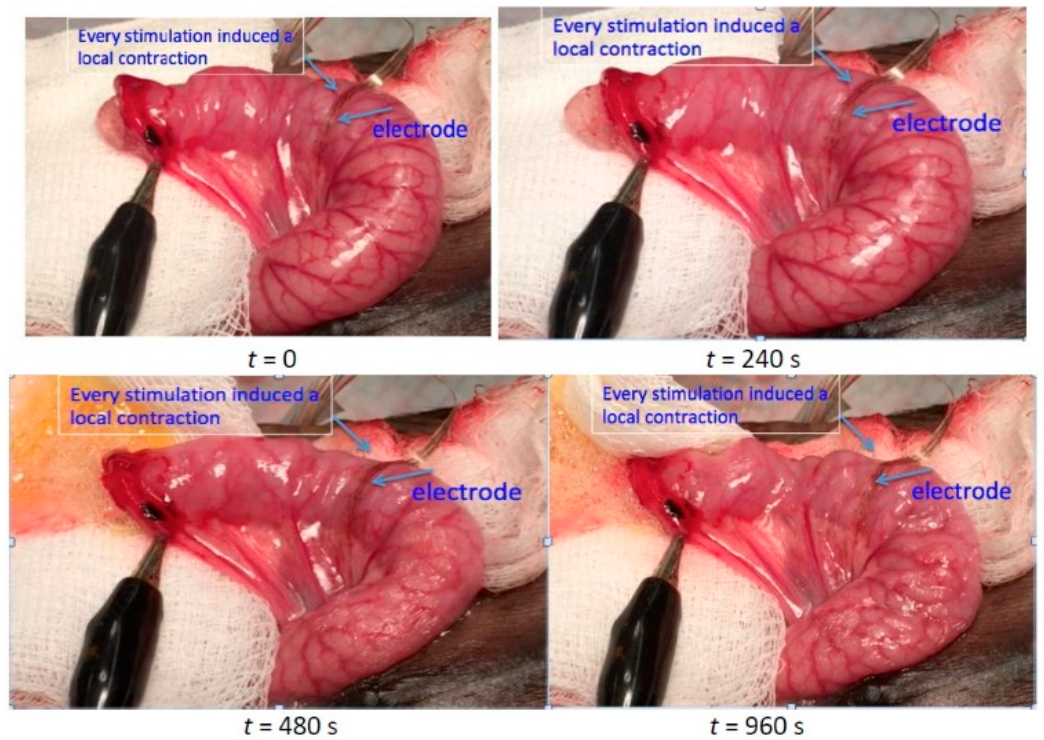
Figure 6. In vivo acute test showing that intestinal local contraction and peristalsis were initiated through the identified stimulation protocol.